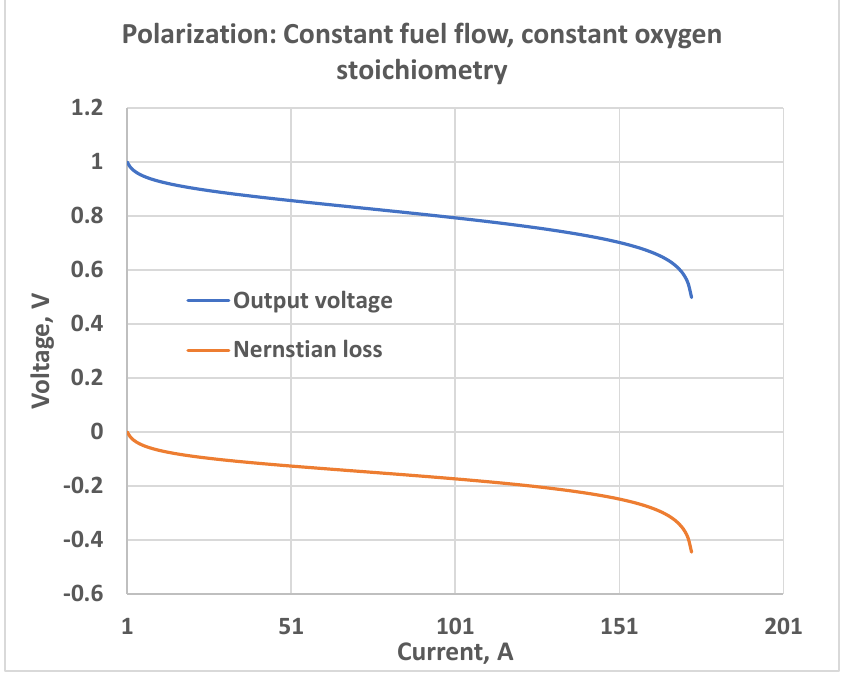
Figure 11. Polarization characteristics (constant hydrogen flow and constant oxygen stochiometry); the Nernst loss is plotted